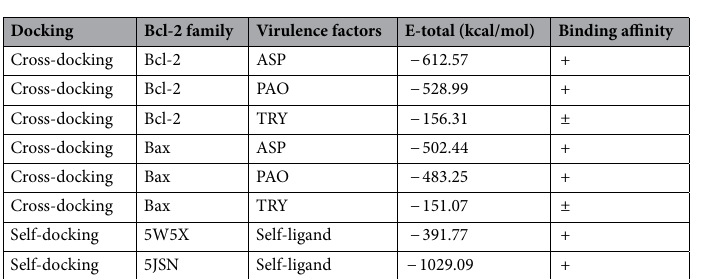
Table 1. Cross-dockings and self-dockings results. + ; high affinity. ± ; low affinity.